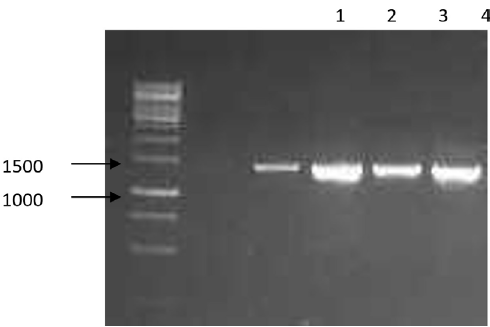
Fig. 1. PCR product with primers 63f and